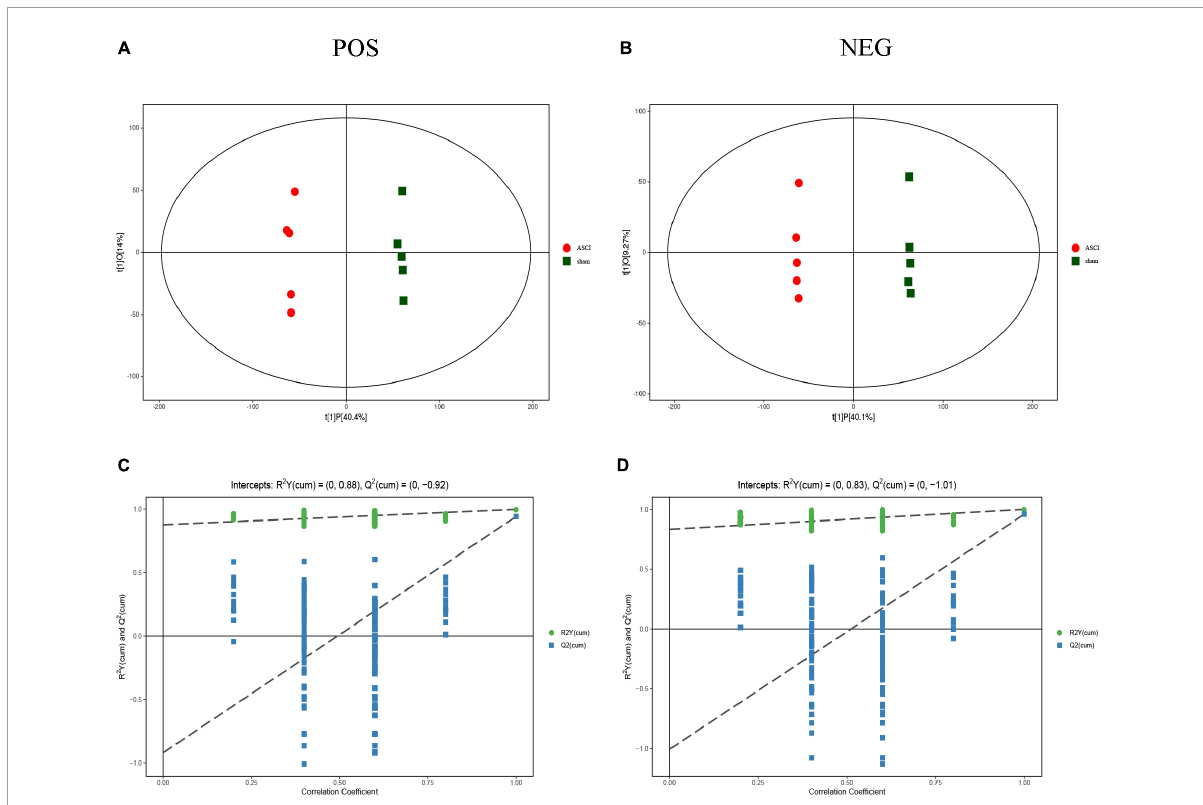
FIGURE2 Score scatter plot of orthogonal projections to latent structures-discriminant analysis (OPLS-DA) model and permutation test of OPLS-DA model for group sham vs. the acute-phase spinal cord injury in both positive ion mode and negative ion mode. (A,B) OPLS-DA model, horizontal axis indicates the predicted principal component scores of the first principal component, demonstrating between-sample group differences, and vertical axis indicates the orthogonal principal component scores, demonstrating within-sample group differences, with each scatter representing a sample and the scatter shape and color indicating different experimental groupings. (C,D) Permutation test of OPLS-DA model shows that the model is good and no overfitting phenomenon. POS, positive ion mode; NEG, negative ion mode; ASCI, the acute-phase spinal cord